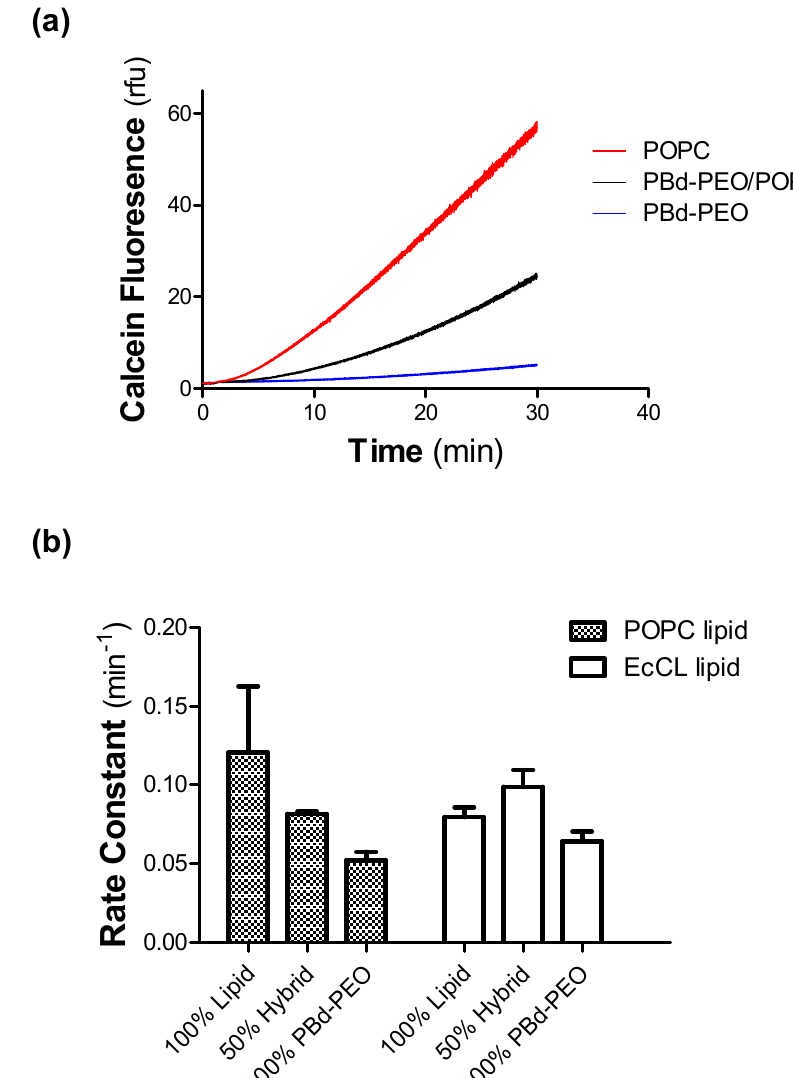
Figure 5. Permeability of two classes of polymersome to the fluorescent probe calcein acetomethoxyl- ester (C-AM). ( a ) The permeability of vesicles was assessed by the enzymatic (porcine carboxyl-esterase) production of fluorescent probe calcein from the non-fluorescent precursor C-AM within the lumen. Vesicles comprised 100 mol% POPC ( red trace ), 100 mol% PBd-PEO ( blue trace ), or hybrid vesicles with 50 mol% of both POPC and PBd-PEO ( black trace ). The C-AM probe (12 μ M) was added to vesicles in quartz silica cuvettes at 37 °C. Fluorescence was measured continuously at λ ex = 488 ± 5 nm and λ em = 515 ± 5 nm. ( b ) The rate constant for the appearance of calcein fluoresence was determined by non-linear regression of logistic Equation (1). Rate constants were measured for vesicles whose lipid component was POPC ( hashed bars ) or EcCL ( clear bars ). Values represent the mean ± SEM obtained from three independent observations.